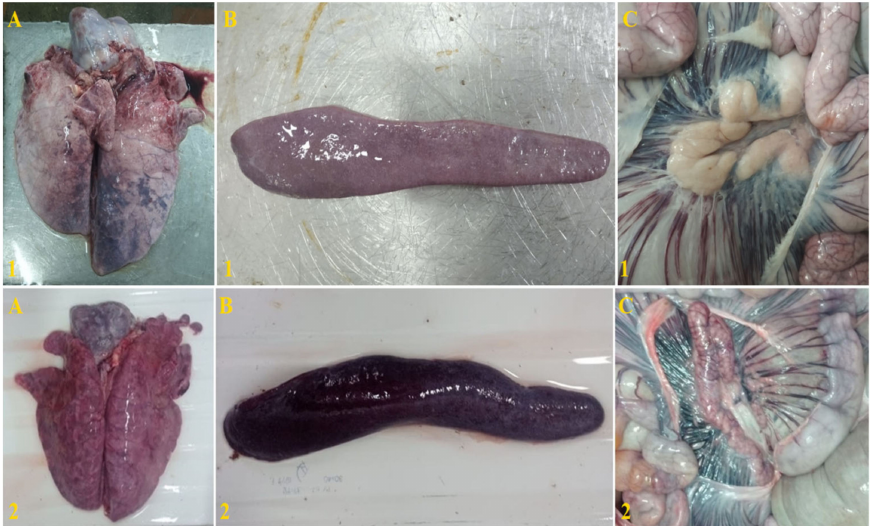
Figure 7. Lungs ( A ), spleen ( B ) and mesenteric lymph nodes ( C ) of pigs: #1 after inoculation with ASFV-Katanga-350, and followed by a challenge with ASFV-Stavropol 01/08; #2 after challenge with ASFV-Stavropol 01/08,